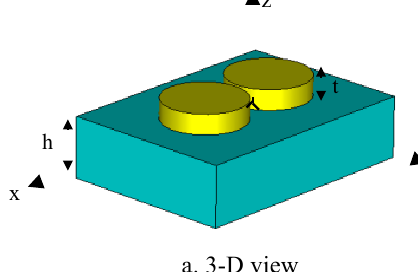
L =5 µm and W =0.5 µm for rectangular dipole, rod rod radius=1.2 µm for wire of cylindrical dipole, and Ψ =20 degrees, L =2.2 µm for a rhombus arms dipole. The s